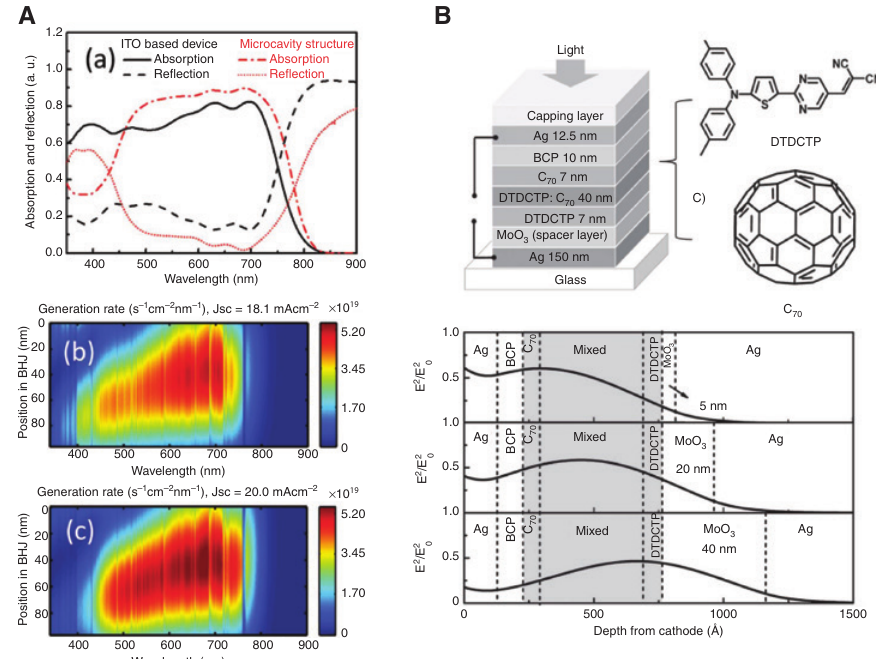
Figure 10: Microcavity-based OPVs and Optical–spacer-based OPVs. (A) Absorption and reflection curves of ITO-based OPVs and microcavity-based OPVs (up), simulated exciton generation profile for ITO-based OPVs (middle) and microcavity-based OPVs (bottom) (reprint with permission Ref. [161]; Copyright 2015 WILEY-VCH Verlag GmbH & Co. KGaA, Weinheim). (B) Device structure and molecular structures of active layer materials, and calculated optical-filed distributions at the wavelength of 590 nm. The gray areas are the active layers (reprint with permission Ref. [163]; Copyright 2012 Wiley-VCH Verlag GmbH & Co. KGaA,